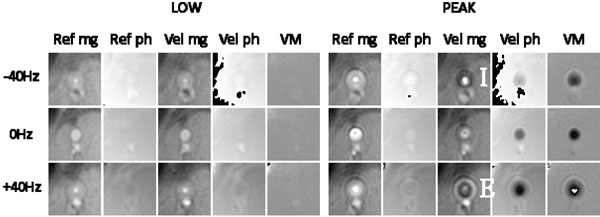
Reference, Ref and Velocity encoded, Vel magnitude and phase images with corresponding velocity maps of the popliteal artery at low and peak velocity at 50cm/s VENC with initial frequency offsets -40, 0, +40 Hz. Low velocity images show symmetric distortion of the artery on ref. and vel. magnitude images while the phase images show a positive phase slope with negative off-resonance and negative phase slope with positive off-resonance; and is similar between ref. and vel. images. Peak velocity shows similar distortions on the ref. magnitude and phase images as at low velocity. The vel. magnitude images show an implosion (I) and explosion (E) effect as the signal loss due to shear phase dispersion is increased and decreased respectively; the vel. phase images show the off-resonance induced phase adding destructively and constructively to the vel. induced phase resulting in varying velocity profiles across the artery in the VMs.